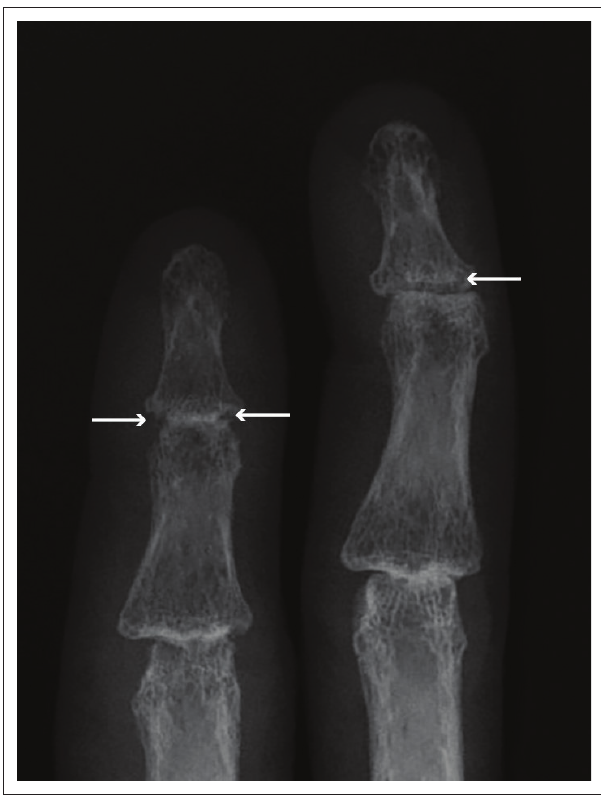
FIGURE 2: Magnified view of the 2nd and 3rd distal interphalangeal joints of the same patient discussed in Figure 1 demonstrates early erosions and irregularity of the distal phalanges (arrows).